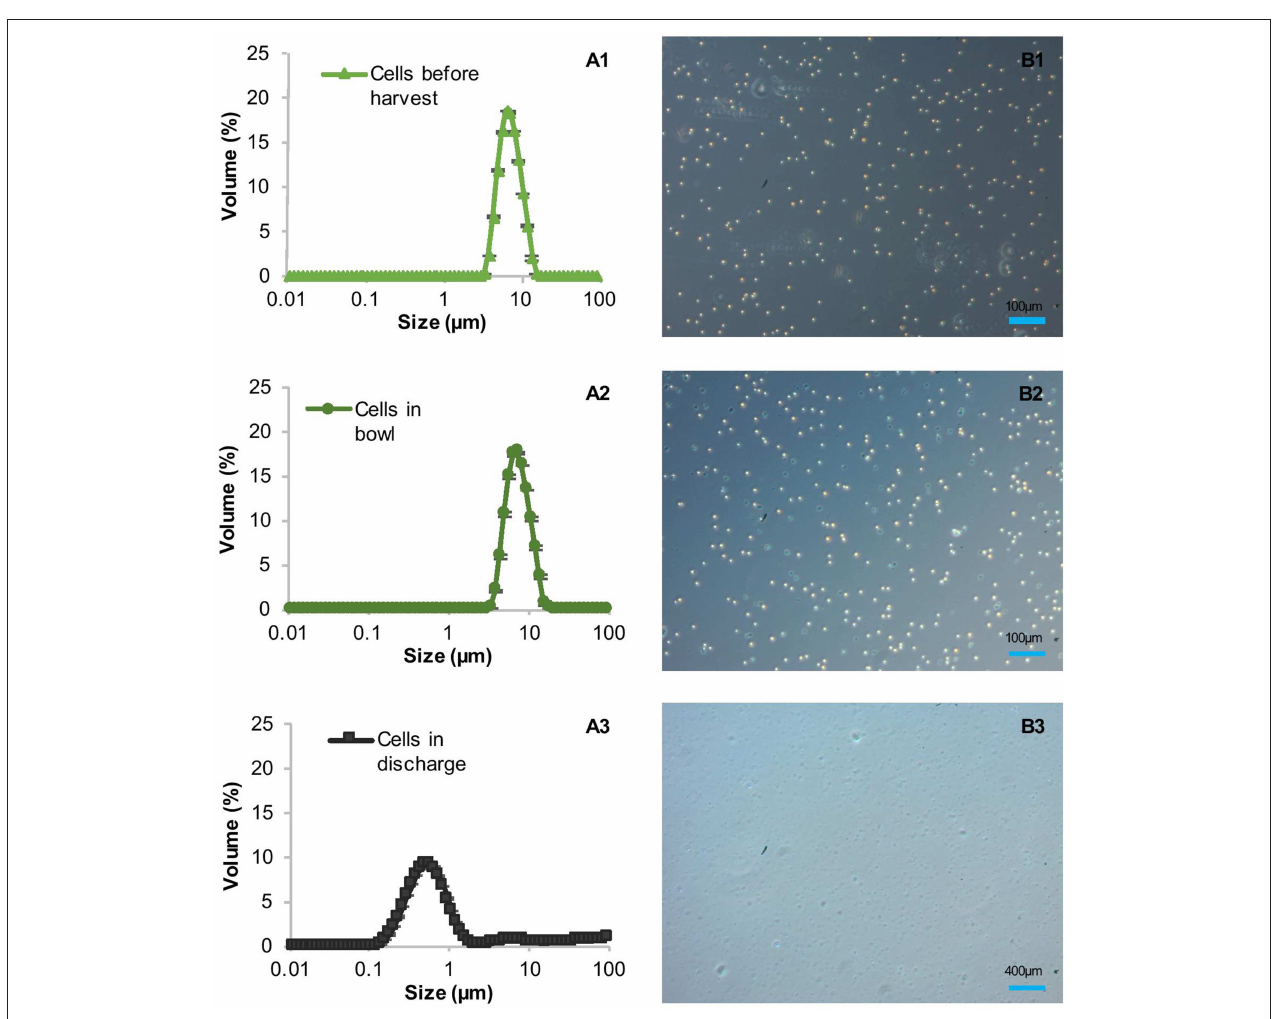
FIGURE 4 | Integrity of Chlamydomonas reinhardtii TN72_pal cells during harvest by continuous-flow intermittent-discharge disc-stack centrifugation. A 100L pilot-scale culture was harvested in a GEA Westfalia CSA-1 at a flow rate of 150L.h − 1 (Q/ 6 65 × 10 − 9 m.s − 1 ). Samples were taken before harvest, from the centrifuge bowl during the run and the discharge after the harvest. The cell integrity was determined by particle size measurements (A1–A3 ) and light microscopy (B1–B3) . Error bars represent ± 1 SD ( n ≥ 5).